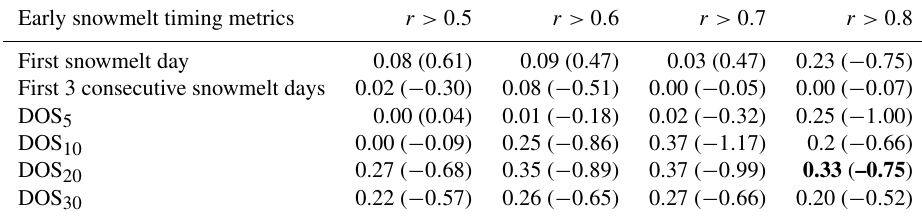
Table A5. Coefficient of determination ( R 2 ) and slope (in parentheses; d ◦ C − 1 ) of the linear regression between the empirical diel streamflow-based model sensitivity to warming and sites’ mean winter air temperature as presented in Fig. 8b, for different early snowmelt day metrics and correlation cutoffs ( r ) between hourly solar radiation and streamflow. DOS xx represent the date when the xx th percentile of snowmelt days occurs. Bolded numbers are associated with the modeling decisions used in the result and discussion